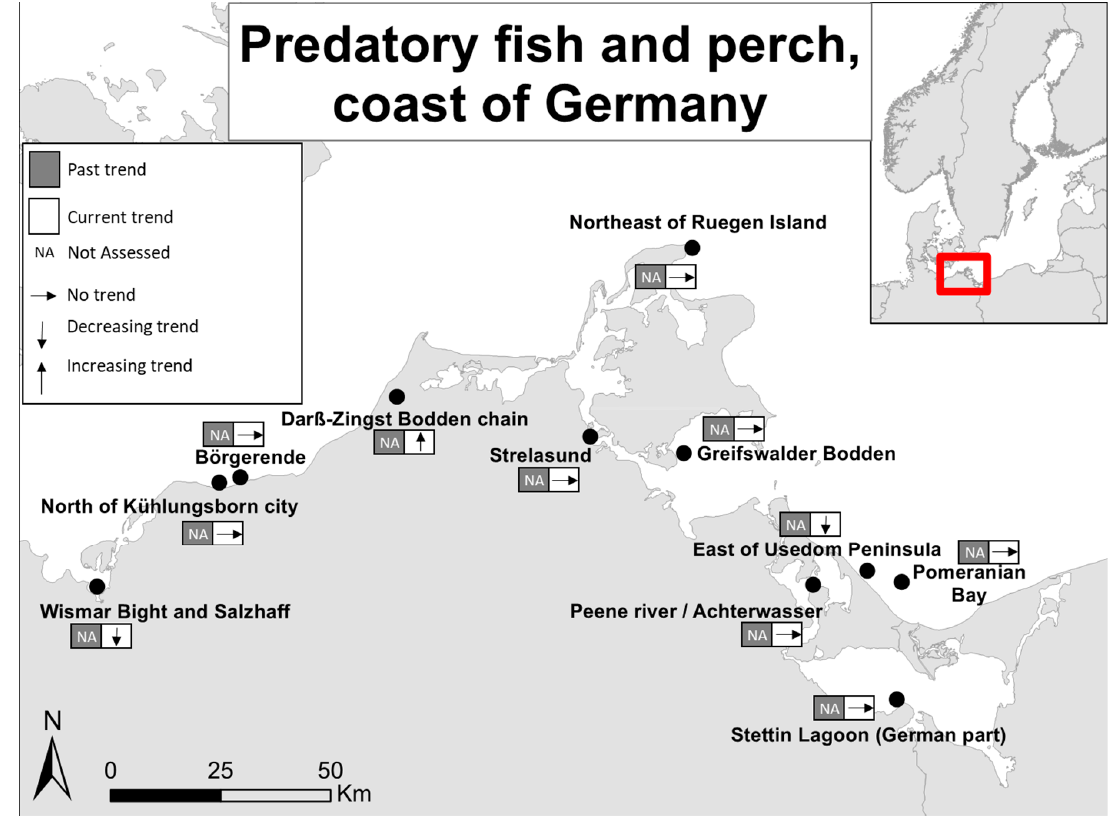
Figure 2. The trends in abundance of coastal predatory fish as a functional group and perch for German areas are showed on this in-zoomed map. An up-ward pointing arrow denote increasing trends in abundance, a horizontal arrow no trend in abundance, and a down-ward pointing arrow a decreasing abundance. NA denotes that no assessment/data is available. For each area, past trends are shown in a grey box and current trends in a white box. Time-period considered in each area and box are outlined in the main text and in Table 1.